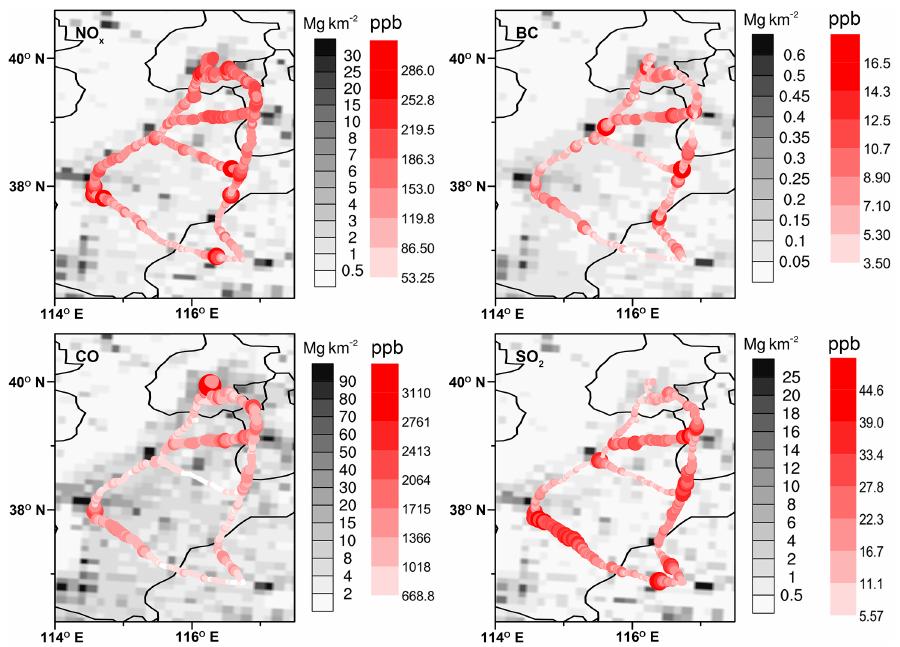
Figure 3. The spatial distributions of the measured concentrations in our study and the emission maps of SO 2 , NO x , CO and BC. The coloured tracks were average concentrations measured in this mobile observation. The black and white maps were emission maps from the year 2010 derived from the MEIC model (Zhao et al.,